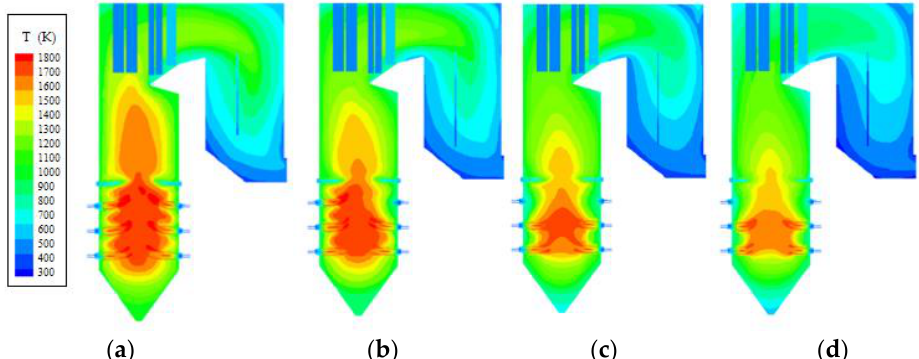
Figure 5. Temperature field distribution under different boiler loads: ( a ) Temperature field distribution under 600 MW boiler load; ( b ) Temperature field distribution under 500 MW boiler load; ( c ) Temperature field distribution under 400 MW boiler load; ( d ) Temperature field distribution under 250 MW boiler load.